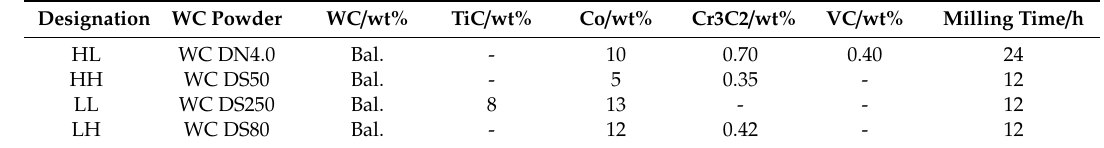
Table 1. Composition of powder mixtures and milling time.